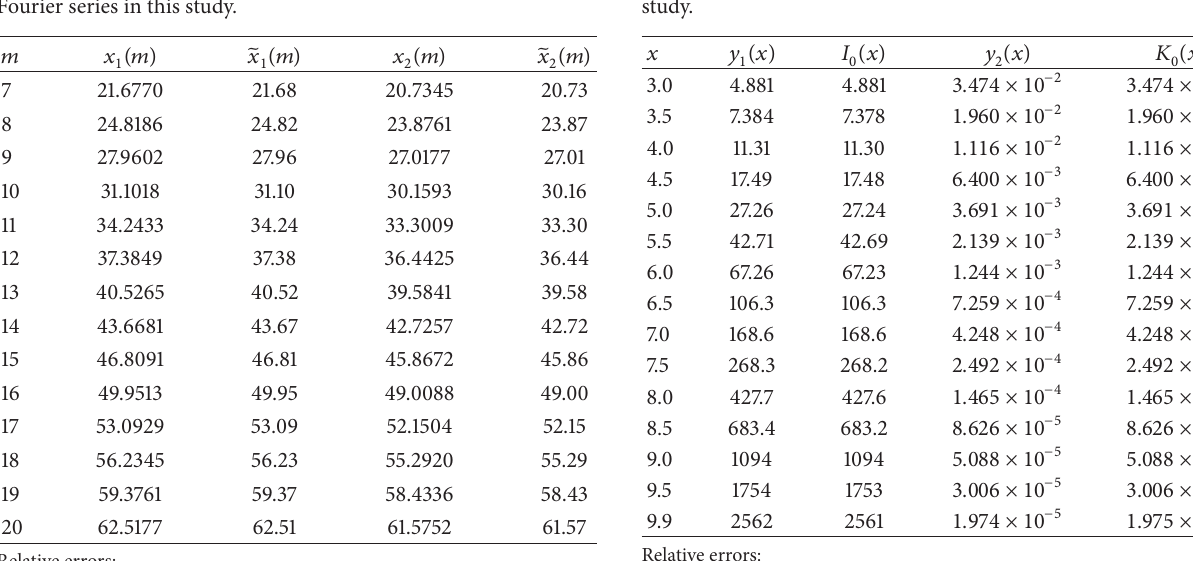
Table 4: Comparisons of the zero points of the Bessel function in Example 1 between the asymptotic formula and the corrected Fourier series in this study.